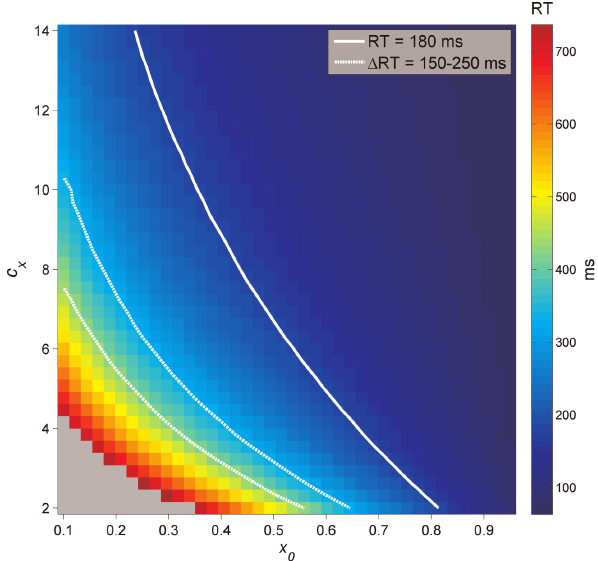
Figure 8. Dependence of RT on the activation potential gain ( c x ) and initial activation ( x 0 ). Bold line shows prepared-response RT =180 ms, dashed lines show corresponding range of D RT =[150, 250] for a given value of c x .